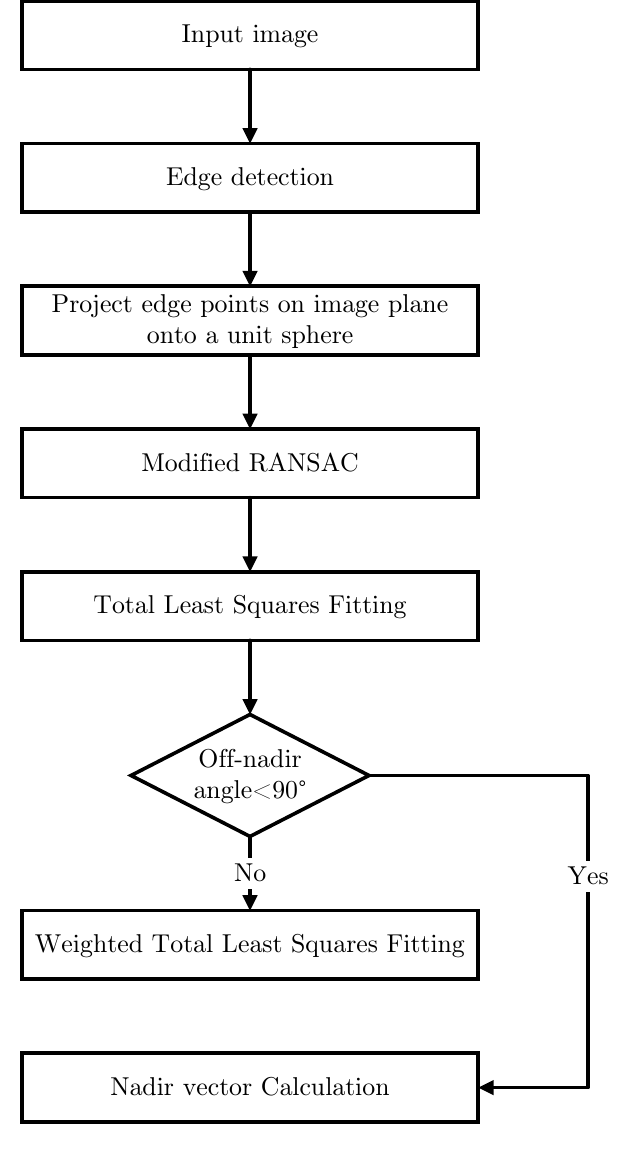
Figure 1. Flowchart of the proposed